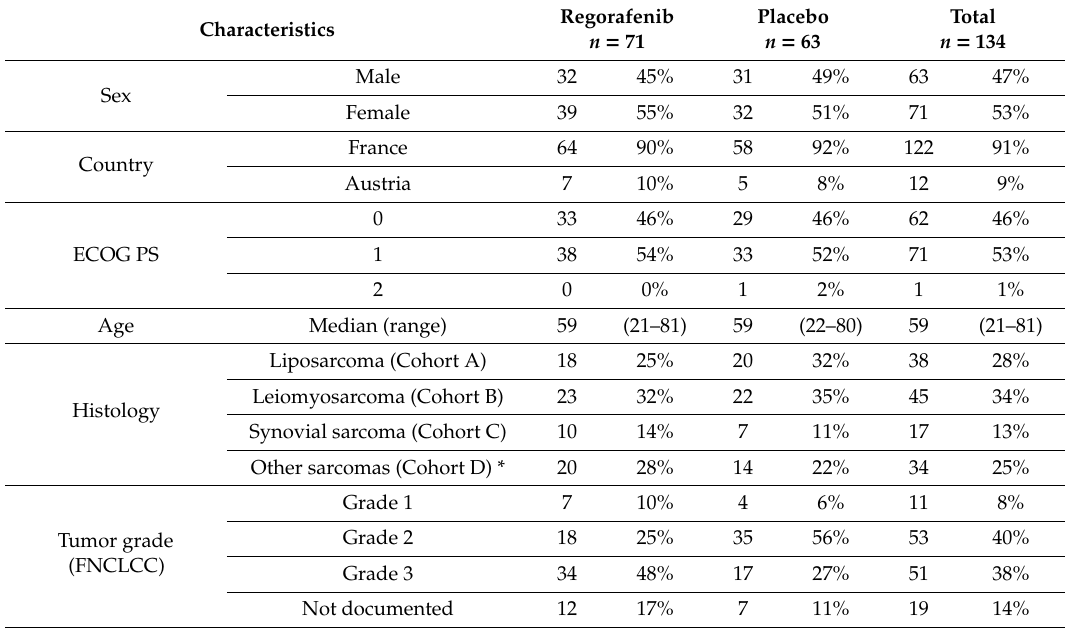
Table 1. Patient and disease characteristics at